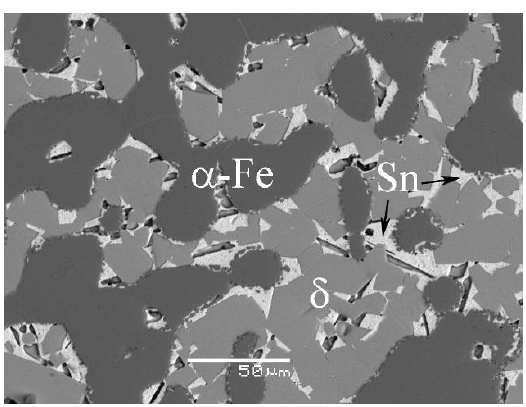
Figure 6. The microstructure of Alloy A6.